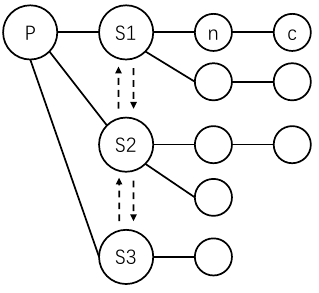
Figure 3. Encoding of the AST.